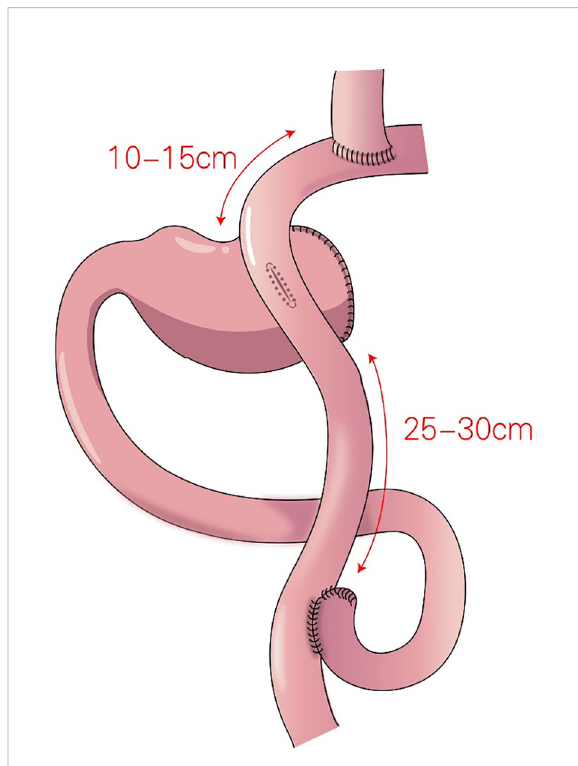
FIGURE 6 Double-tract reconstruction (DTR): Roux-en-Y anastomosis of the esophagus and jejunum is performed fi rst, the jejunum 10 – 15 cm from the anastomotic stoma of the remnant stomach, and the esophagus-jejunum are anastomosed